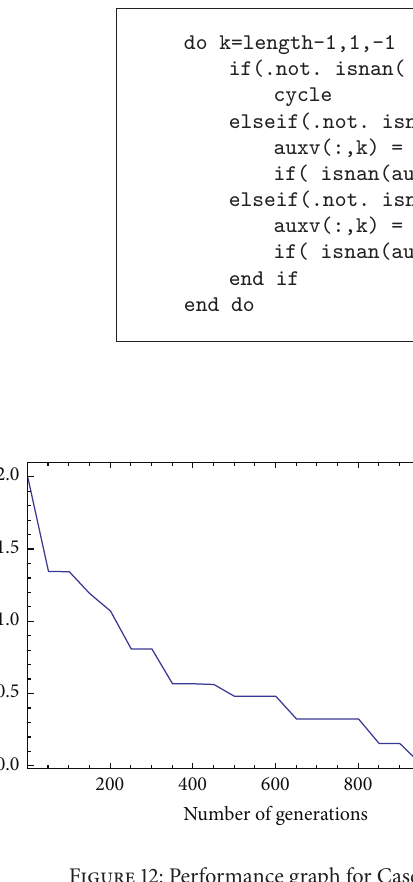
Figure 14: Performance graph for Case 4.